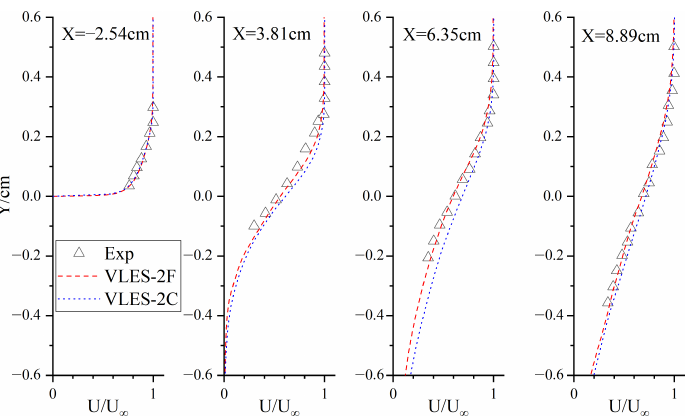
Figure 11. Comparisons of mean streamwise velocity profiles on different grids using the VLES-2 model.